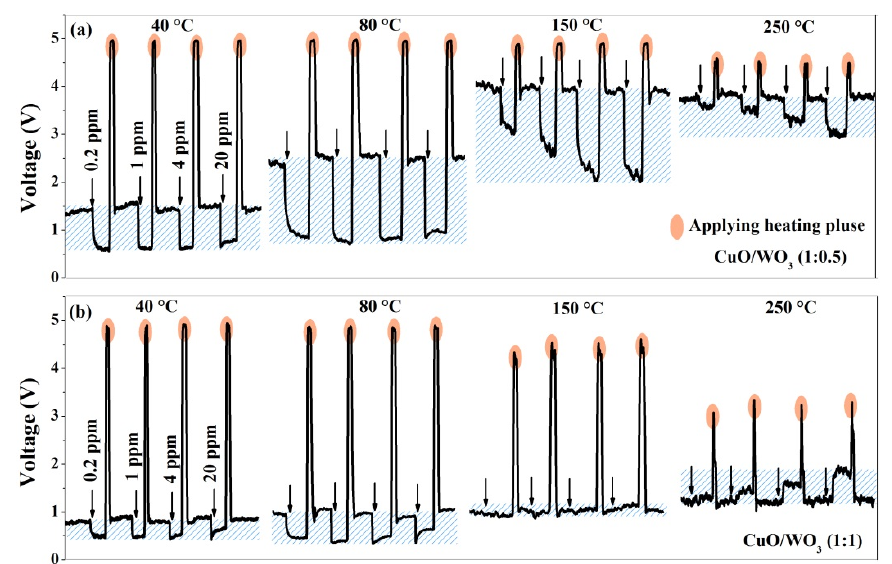
Figure 6. Dynamic curves of ( a ) the CuO/WO 3 (1:0.5) sensor and ( b ) the CuO/WO 3 (1:1) sensor to 0.2, 1, 4, and 20 ppm of H 2 S gas at different temperatures.